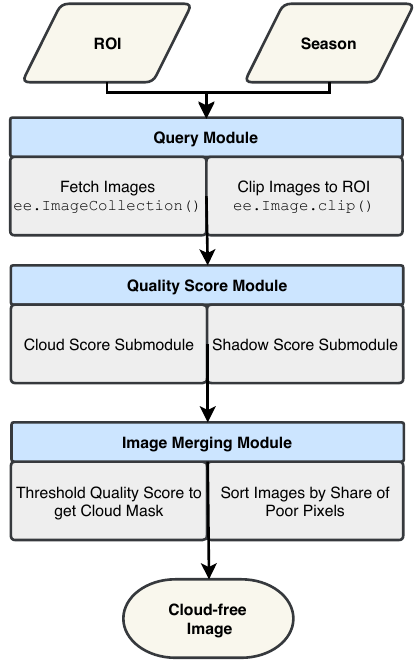
Figure 2. Overall workflow of the GEE-based procedure for cloud-free Sentinel-2 image generation presented in this